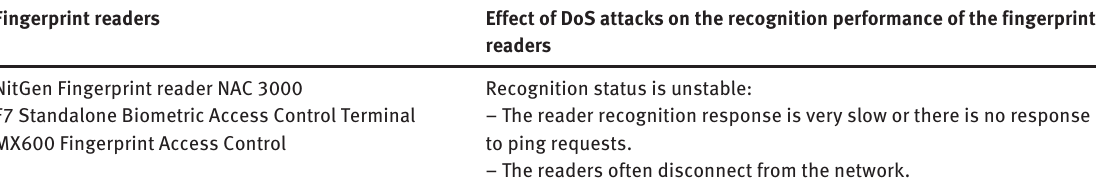
Table 1. DoS Attacks Results for Fingerprint